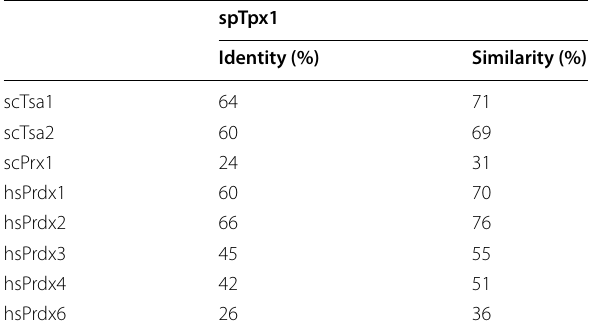
substitution/aa/year, respectively. Next, 28 GPXs were used to estimate the mutation rate, the evolutionary rate